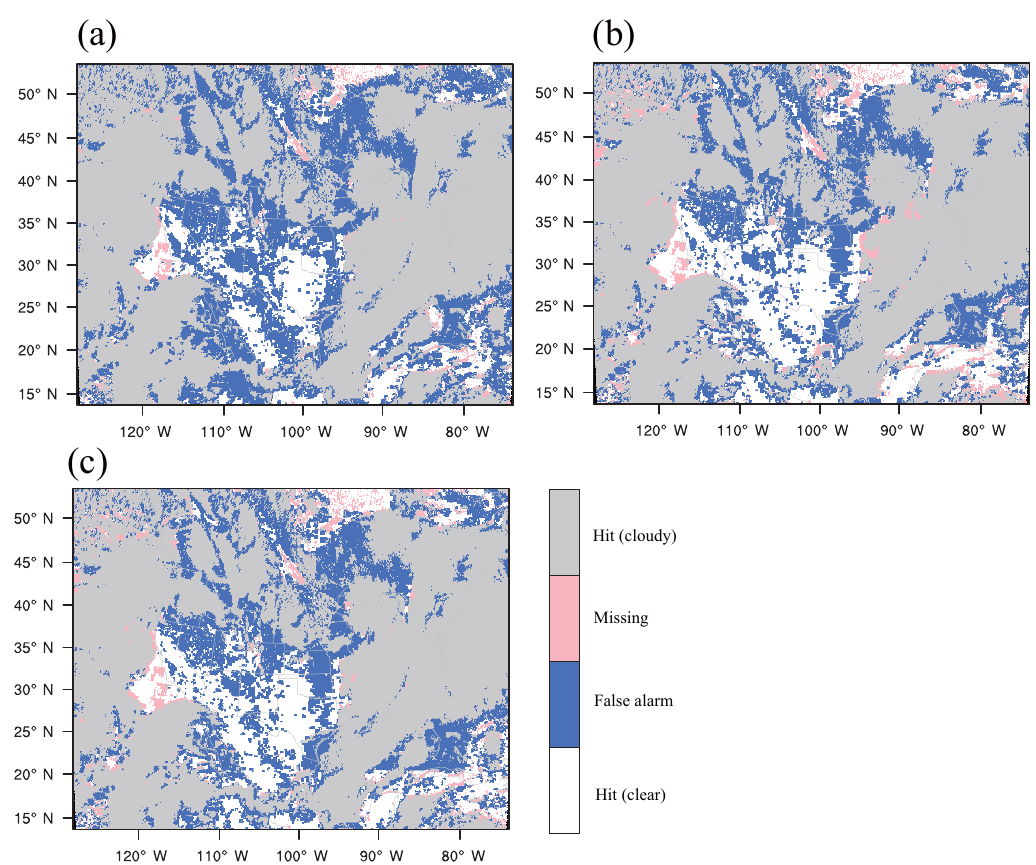
Figure 6. The false alarms, misses and hits for clear and cloudy event locations with (a) the MMR method, (b) the APF method and (c) the APF method but without the group 1 particles (see text for detailed explanations) valid at 07:00UTC, 15 December